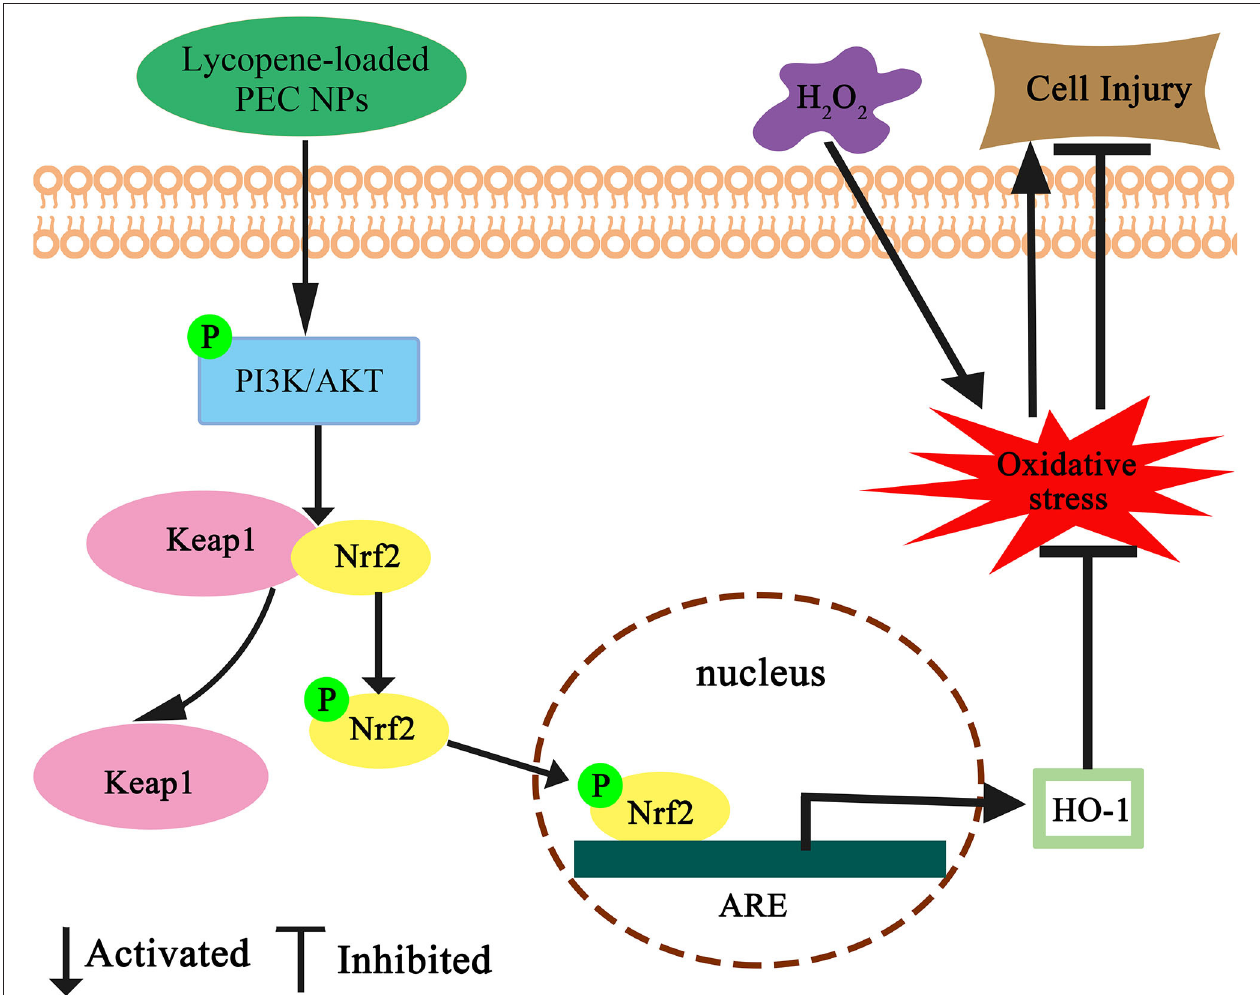
FIGURE 14 | Schematic diagram for the protective effect of lycopene-loaded PEC NPs against oxidative stress in L02 cells. Where ↑ indicates increase, ↓ indicates a decrease.